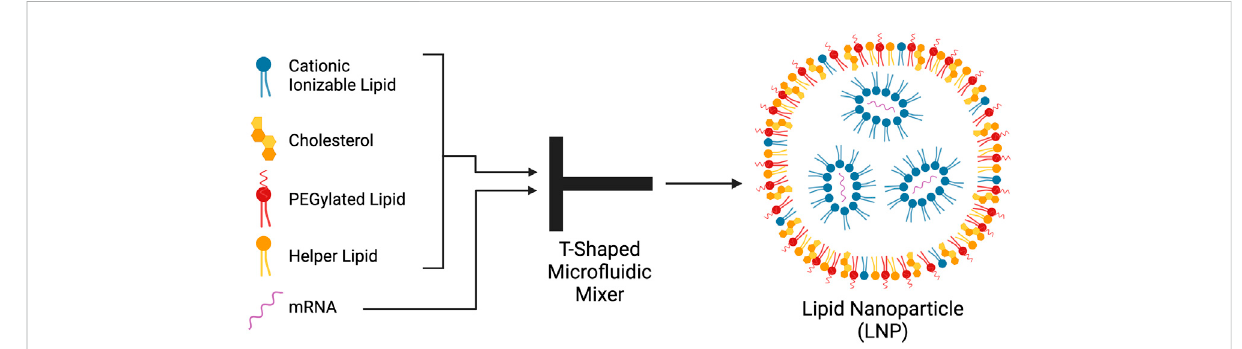
FIGURE 2 Components, structure and method of production of lipid nanoparticles (LNP). Cationic ionizable lipids cholesterol, PEGylated lipids, and helper-lipidsaredissolvedinethanolandmixed withmRNAinwater inaT-shaped micro fl uidic mixer.The